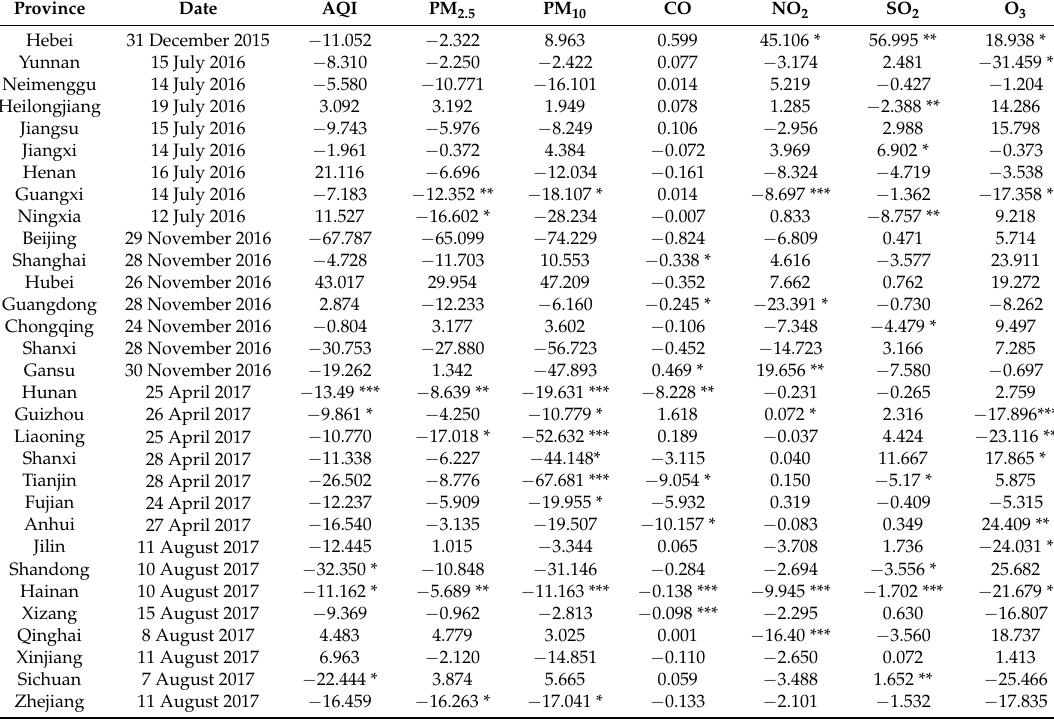
Table A2. Differences in air quality control capabilities among